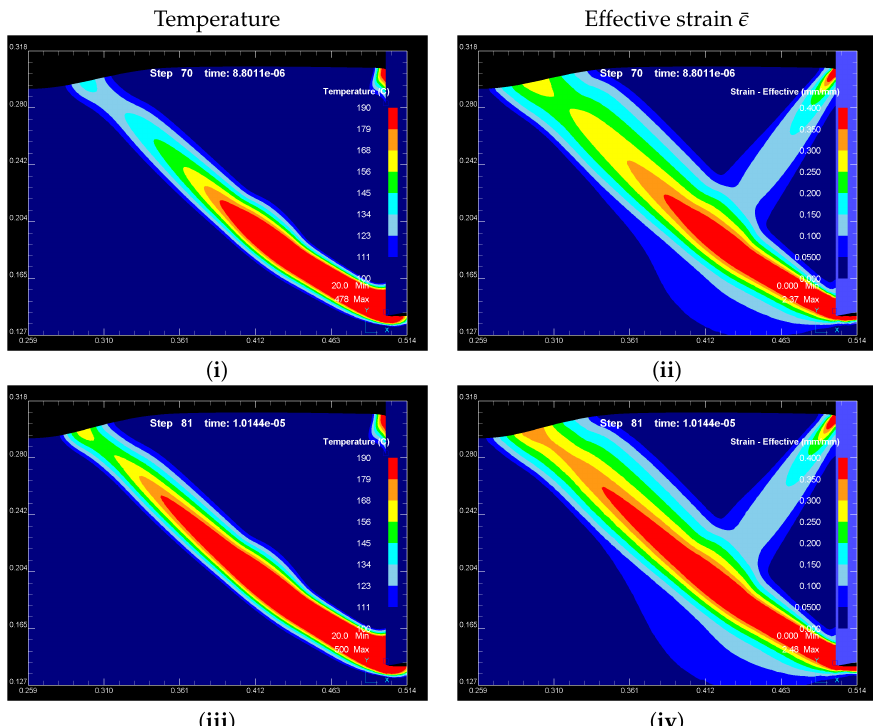
Figure 14. The phenomenon of temperature rise and effective strain localization at the free surface before the ASB reaches the free boundary; snapshots are taken at: ( i , ii ) t = 8.80 µ s, and ( iii , iv ) t = 10.14 µ s (cutting speed v = 200 m/min, feed =150 mm/rev, rake angle γ = 0 ◦ , CDV =